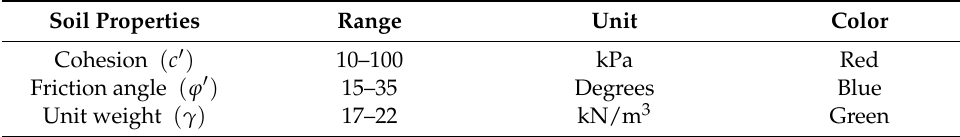
Table 3. Range of soil properties used in this